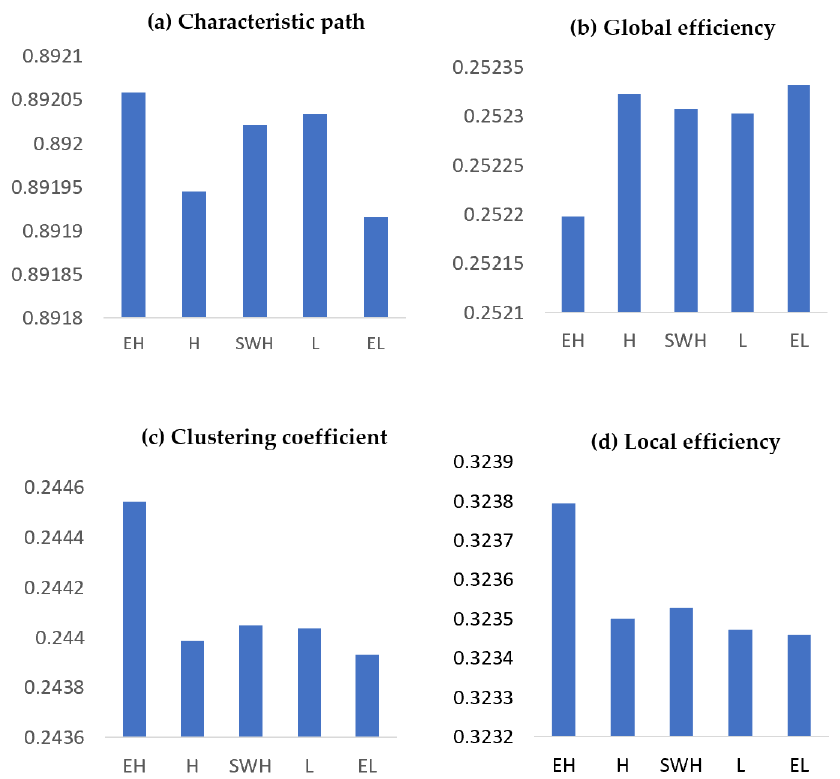
Figure 14. Graph theoretical network metrics showing the primary effects of various exertion levels. ( a ) Characteristic path length. ( b ) Global efficiency. ( c ) Clustering coefficient. ( d ) Local efficiency for beta coherence. EL: extremely light, L: light, SWH: somewhat hard, H: hard, and EH: extremely hard.